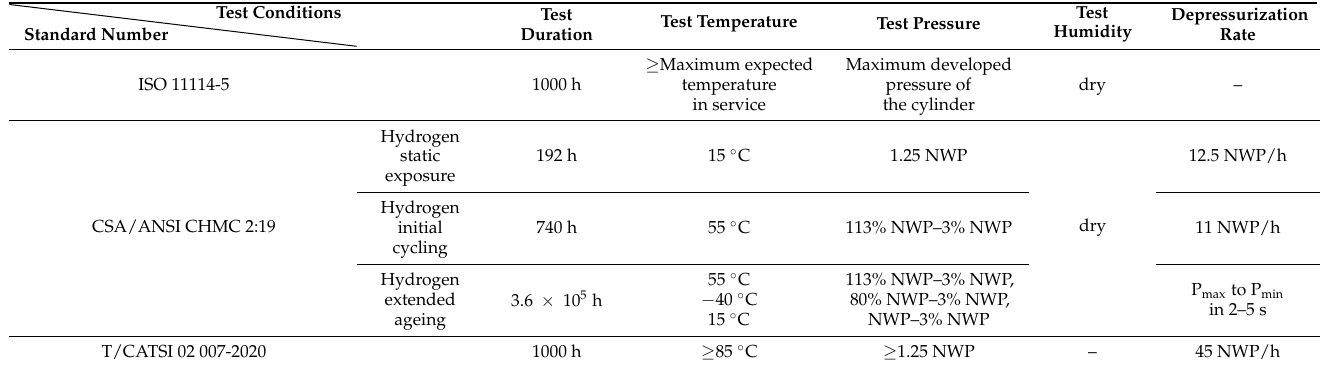
Table 6. Comparison of ageing test conditions among the three existing